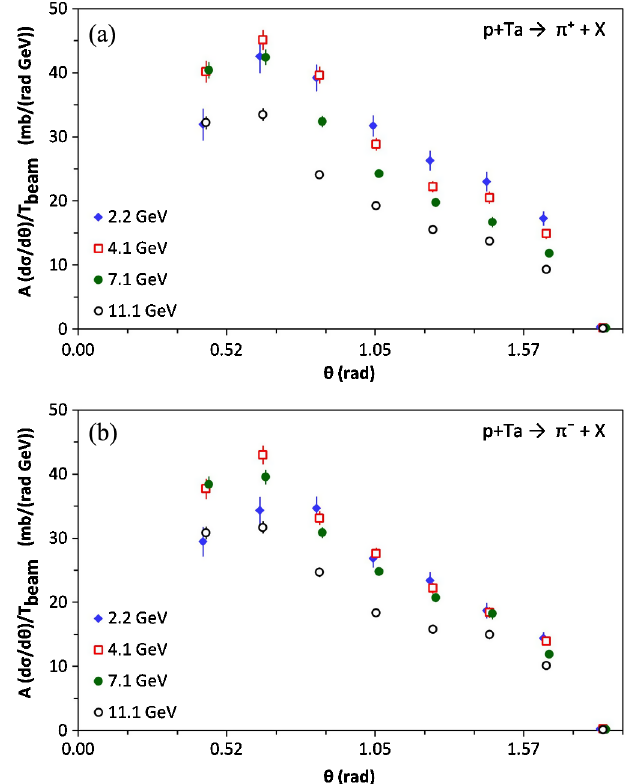
FIG. 7. Acceptance-weighted differential cross section, inte- grated over momentum, divided by beam energy, using the HARP cross section data for (cid:3) þ . The points for T beam ¼ 2 : 2 GeV and 7.1 GeV have been displaced by (cid:1) 10 mrad and þ 10 mrad , respectively, for clarity of presentation. The error bars represent the total uncorrelated errors [11]. The cross sections at different beam energies have similar shapes. All have a maximum